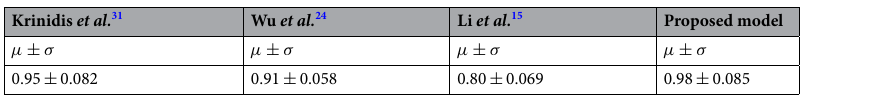
Table 2. Sørensen-Dice similarity for Krinidis et al. 31 , Wu et al. 24 , Li et al. 15 and of our proposed model on 10 different images, µ = mean, σ =